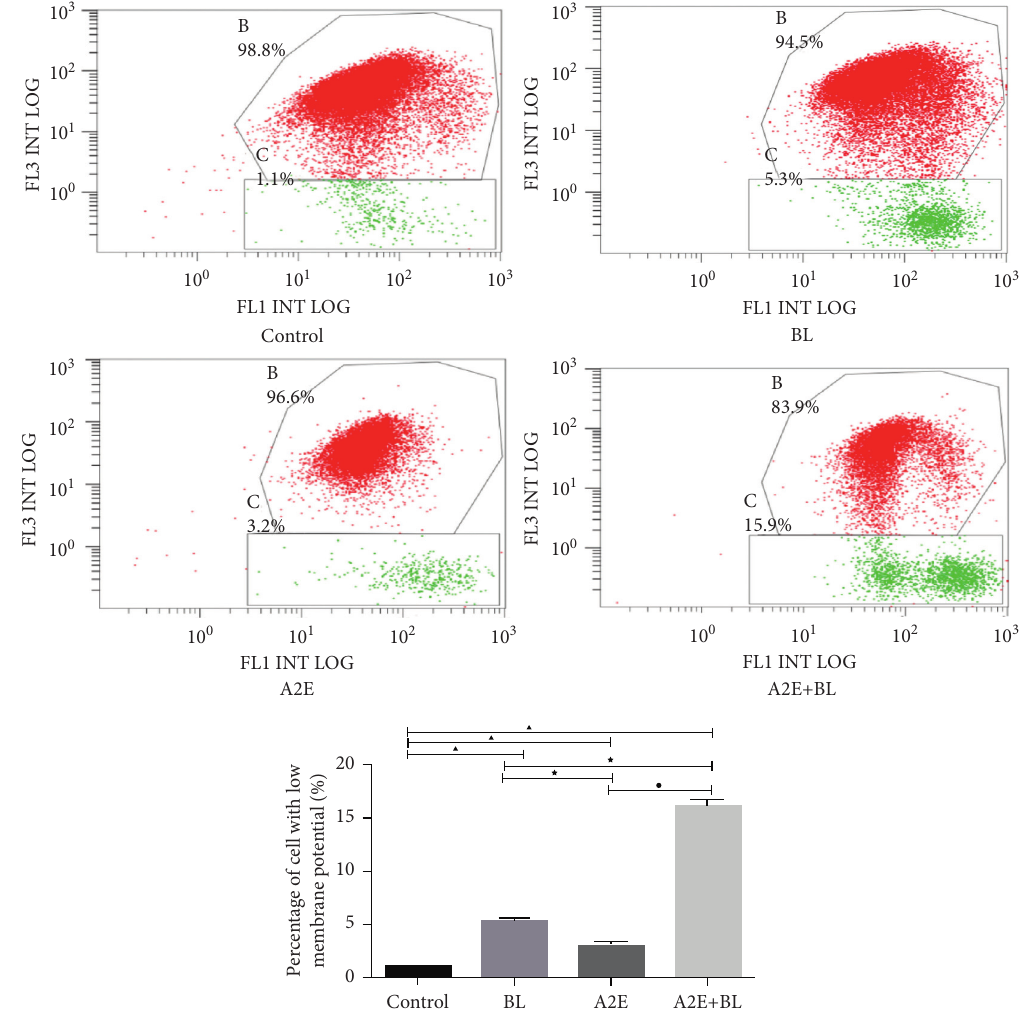
Figure 5: Mitochondrial membrane potential. The mitochondrial membrane potential in the indicated groups was analyzed by flow cytometry with JC-1-stained RPE cells. The decrease in the mitochondrial membrane potential was detected by the transition of JC-1 red fluorescence (FL-3) to JC-1 green fluorescence (FL-1). Statistical analysis of RPE cells with low Δ ѱ m (%) (the percentage of the cells in C). Data are shown as the mean ± SD ( n � 3). An LSD test following one-way ANOVA was performed. Compared to the control group, ▲ P < 0 . 05; compared to the BL group, ★ P < 0 . 05; compared to the BL+NFD group, ● P < 0 . 05; and compared to the A2E group, ◇ P < 0 .